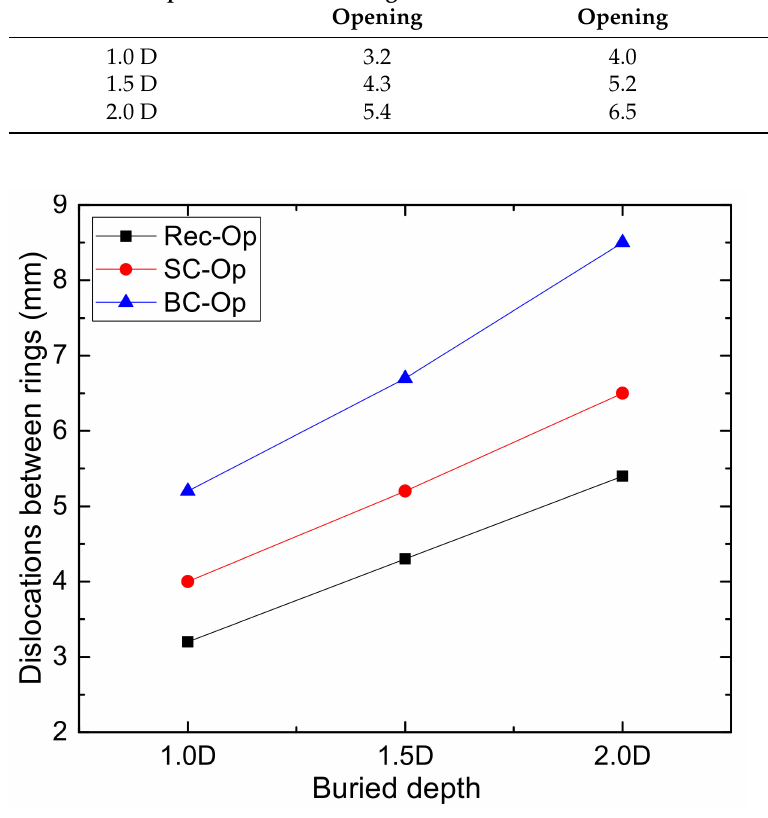
Figure 12. Variations of the dislocations versus buried